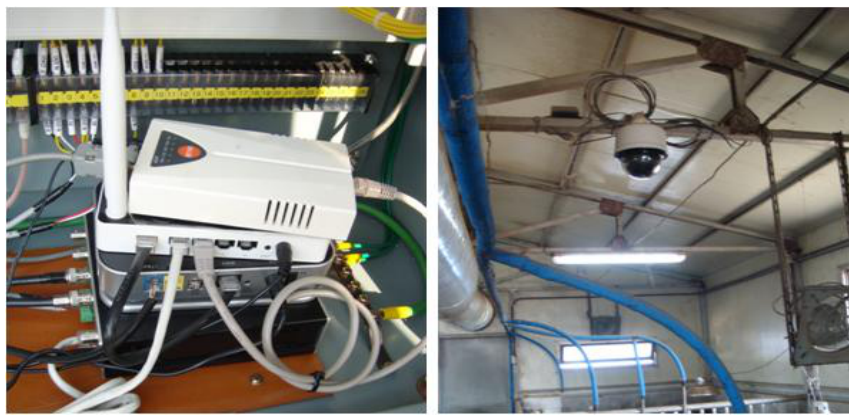
Figure 13. DVR and